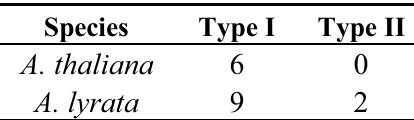
Table 3. Number of independent duplications of Type I and Type II MADS-box genes in A. thaliana as compared to A. lyrata.